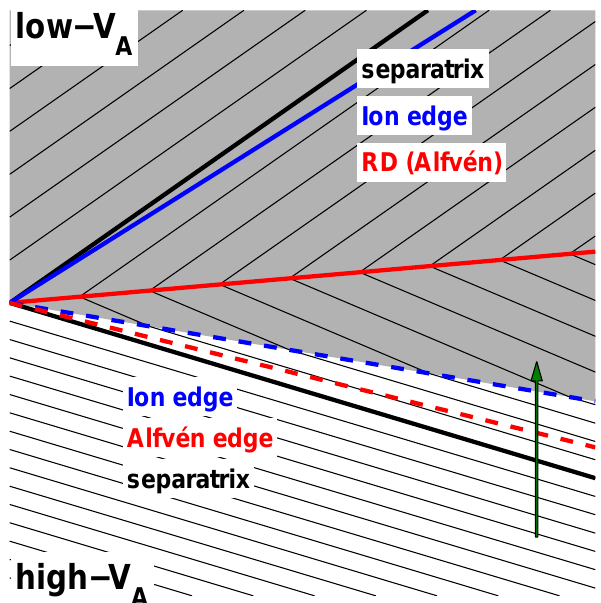
Fig. 1. Sketch of the main boundaries in reconnection when the Alfv´en velocity within one of the reconnecting regions is higher than in the other. All the angles are magnified by about a factor of four to better illustrate the different boundaries. Plasma param- eters are typical for reconnection at the Earth magnetopause. Elec- trons move much faster than ions and therefore their edges are very close to the separatrices and we do not show them explicitly. The green arrow illustrates how a spacecraft is crossing the boundaries in the observational example shown in Fig. 3. Plasma parameters = 5 V low ,B high = 2 B low . Thermal velocity of ions on are: V high A A the high- V A side is assumed to be V high t = 10 V low . The shaded A area shows the region that is dominated by low- V A side